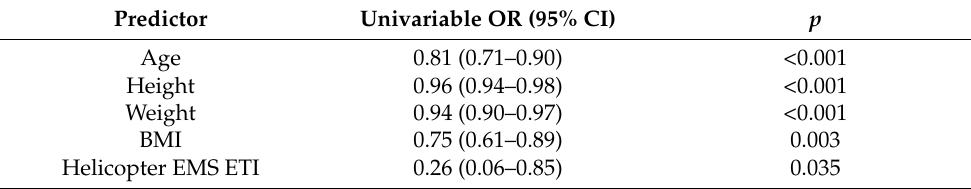
Table 2. Significant univariable risk factors associated with tracheal tube misplacement.